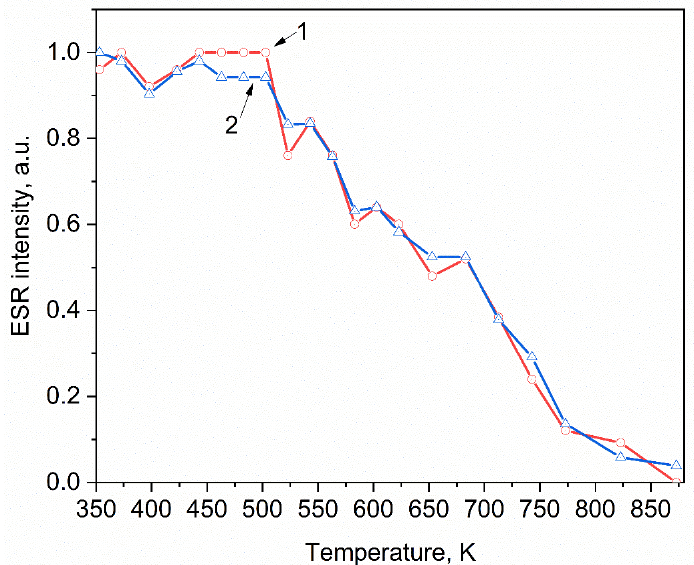
Figure 5. Dependence of the intensity of ESR signals with g = 1.986 (1) and g = 1.963 (2) on the heating temperature of ZrO 2 samples irradiated with xenon ions.